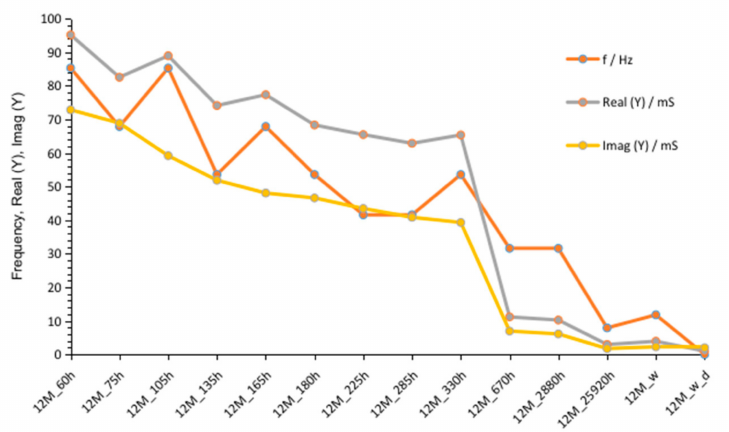
Figure 16. Changes of frequencies, admittance, and susceptance depending on time passed from